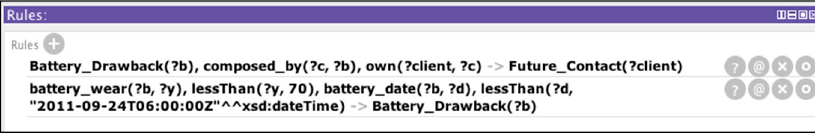
Figure 17. Protégé rule tab containing the inference queries.